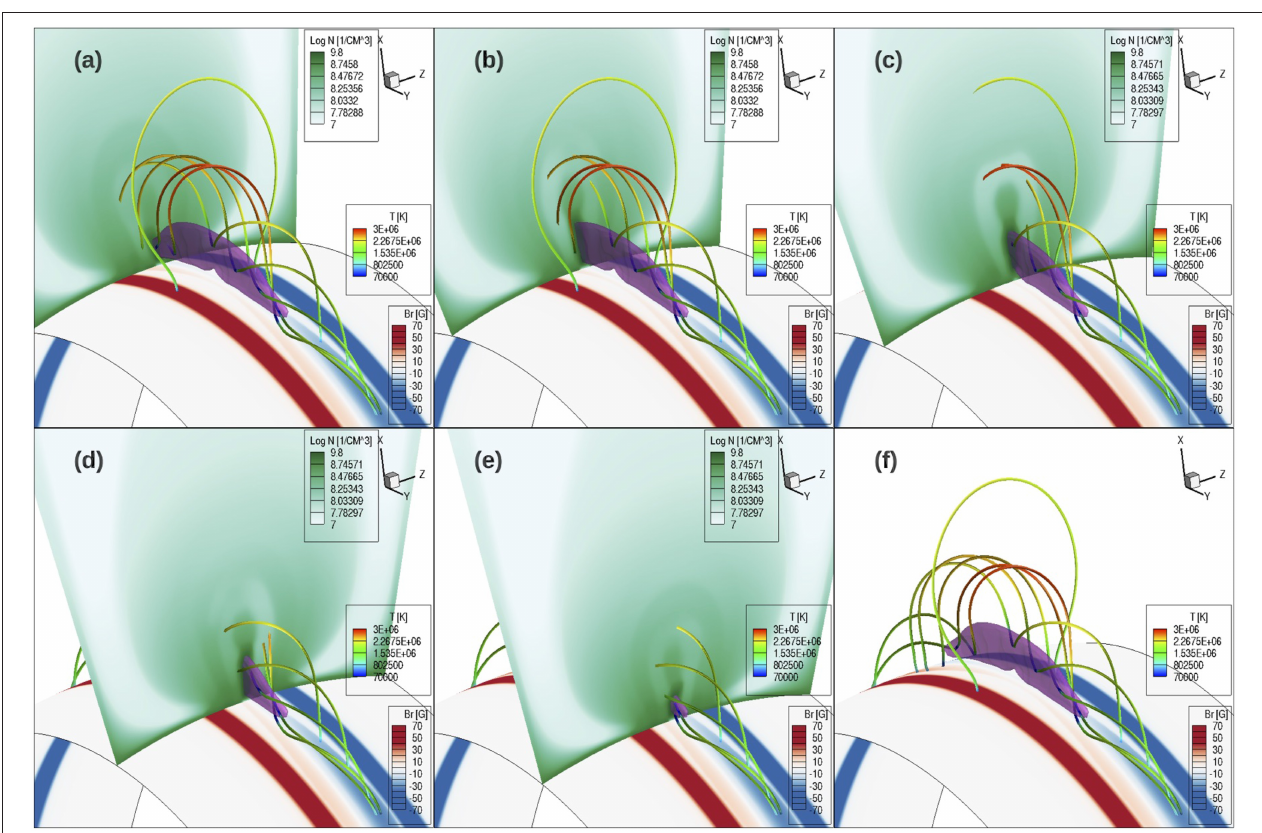
FIGURE 9 | A set of prominence-carrying field lines containing prominence dips and one representative arcade dome field line, all colored with temperature, plotted with a cross-section of density placed at different locations along the flux rope for the different panels (a–e) . (f) shows the same field lines without the density cross-section. A pink iso-surface of temperature at T = 7.5 × 10 4 K outlines the location of the prominence condensation. The lower boundary surface is colored with the normal magnetic field strength. All the images are at the time t = 13.88hr during the quasi-static stage.